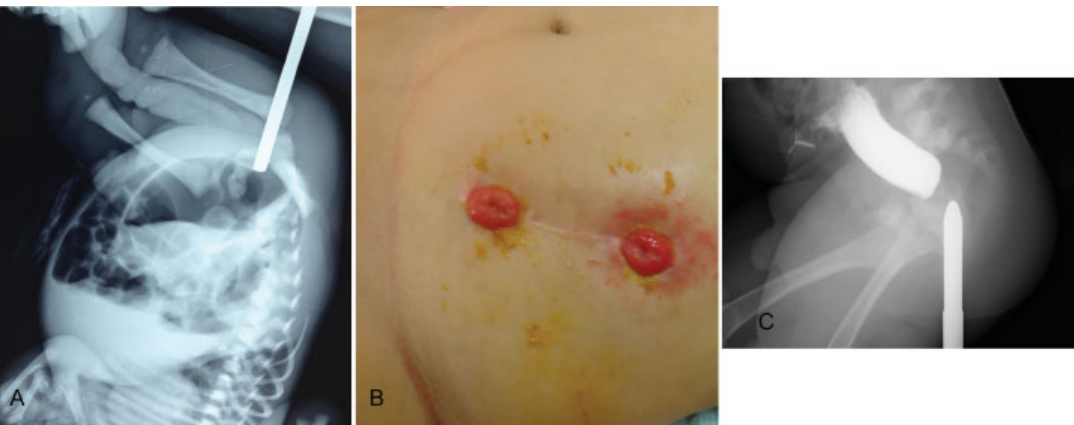
Fig. 1 ( A ) Invertogram showing that the dilator contacted the air column in the distal intestine and the air- fl uid levels at 28 hours of age. ( B ) Diverting sigmoid colostomy when the patient was 8 months old. ( C ) Distal cologram showing the rectal atresia without any fi stula with an (cid:1) 1.5 cm atretic